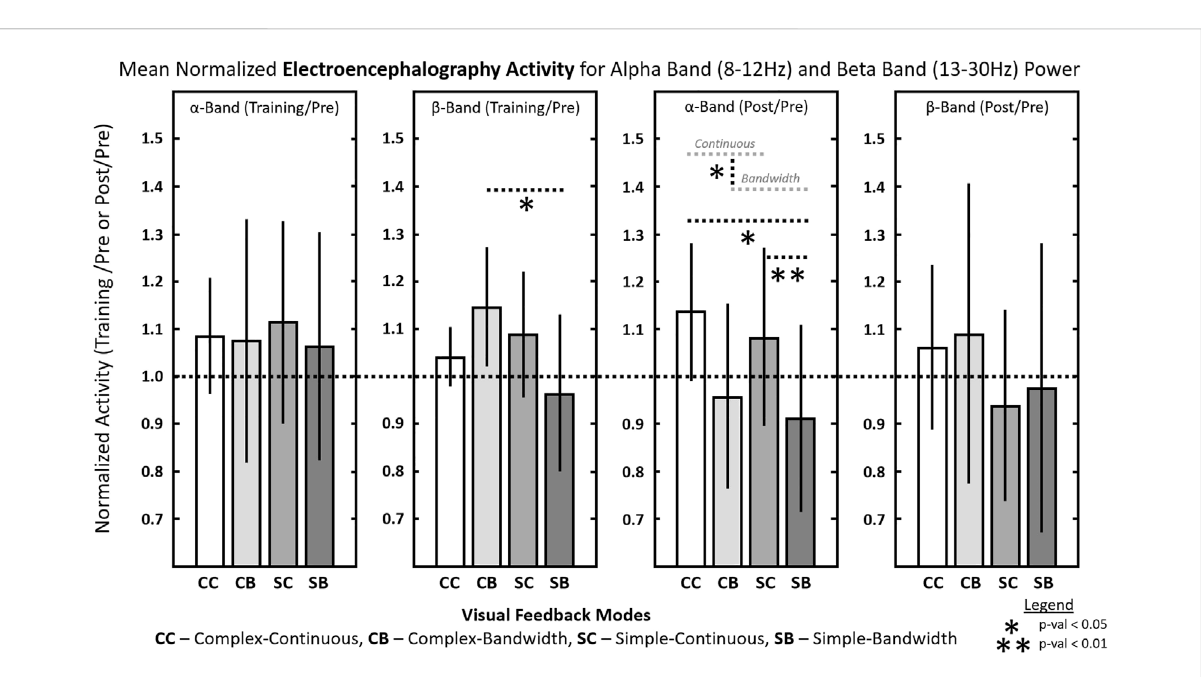
FIGURE 6 Electroencephalography results indicate change in alpha or beta band power during either training or post-training from pre-training.